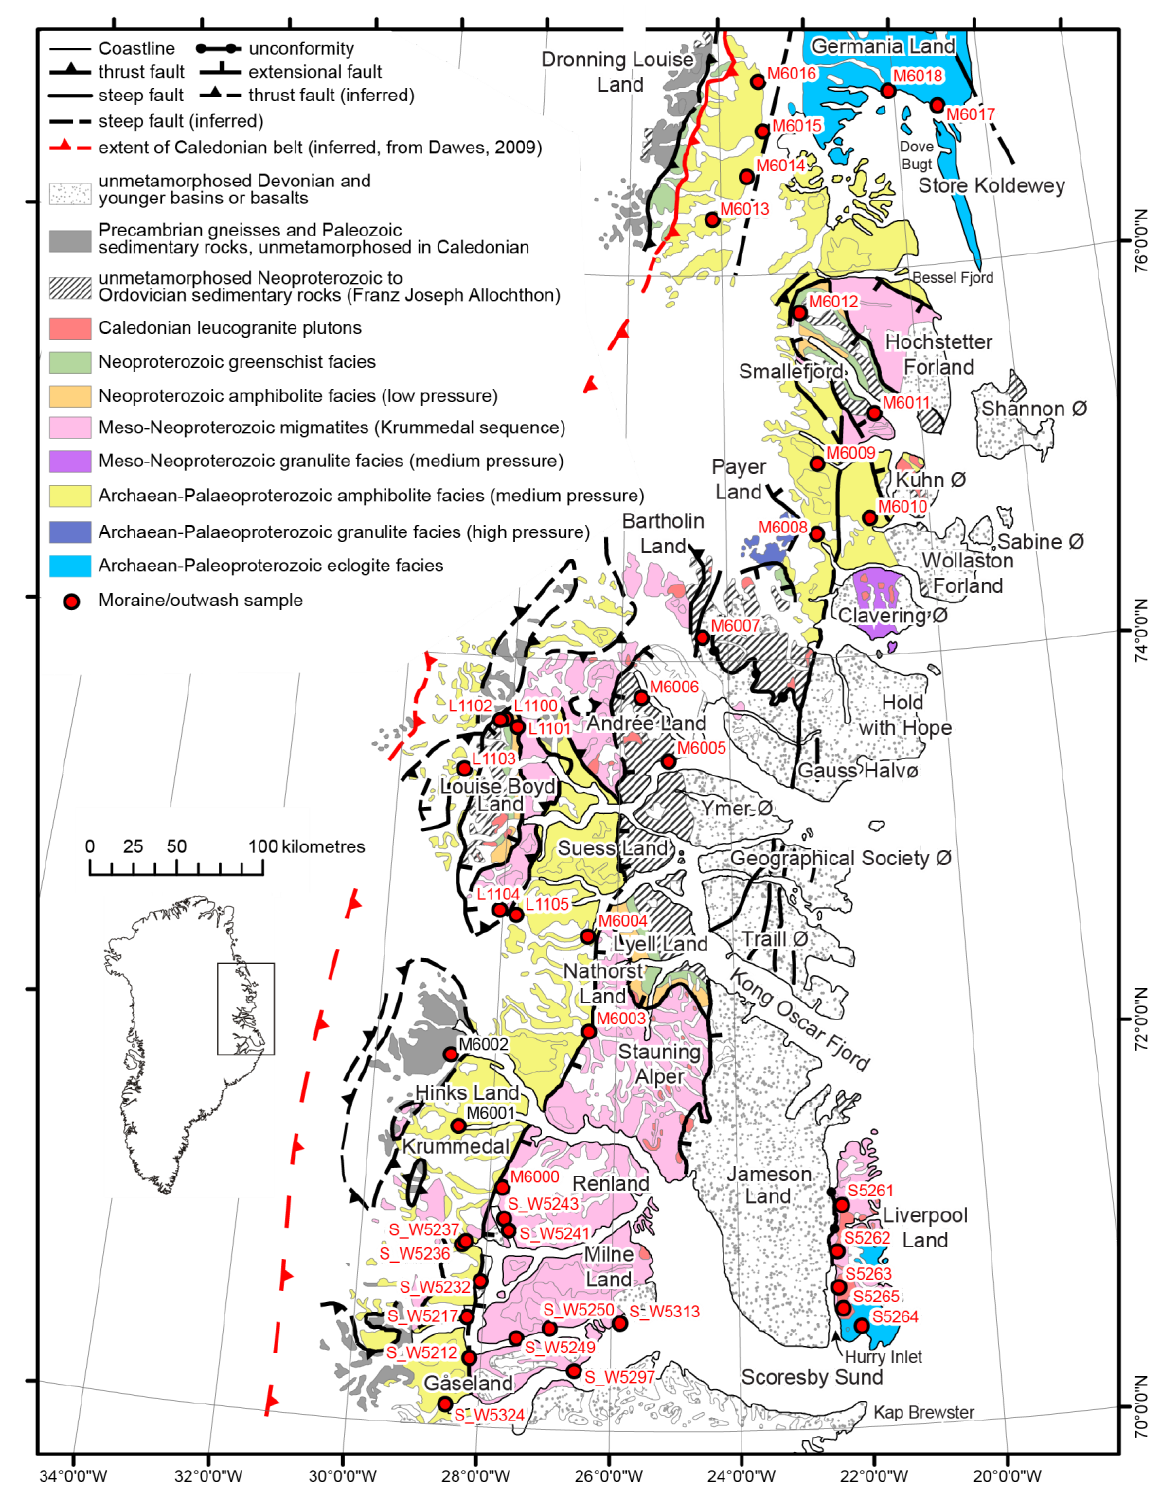
Figure 1. Regional metamorphic facies showing the peak metamorphic conditions [8] for the East Greenland Caledonides between 70 and 77° N, and the position of moraine/outwash samples examined in this study.